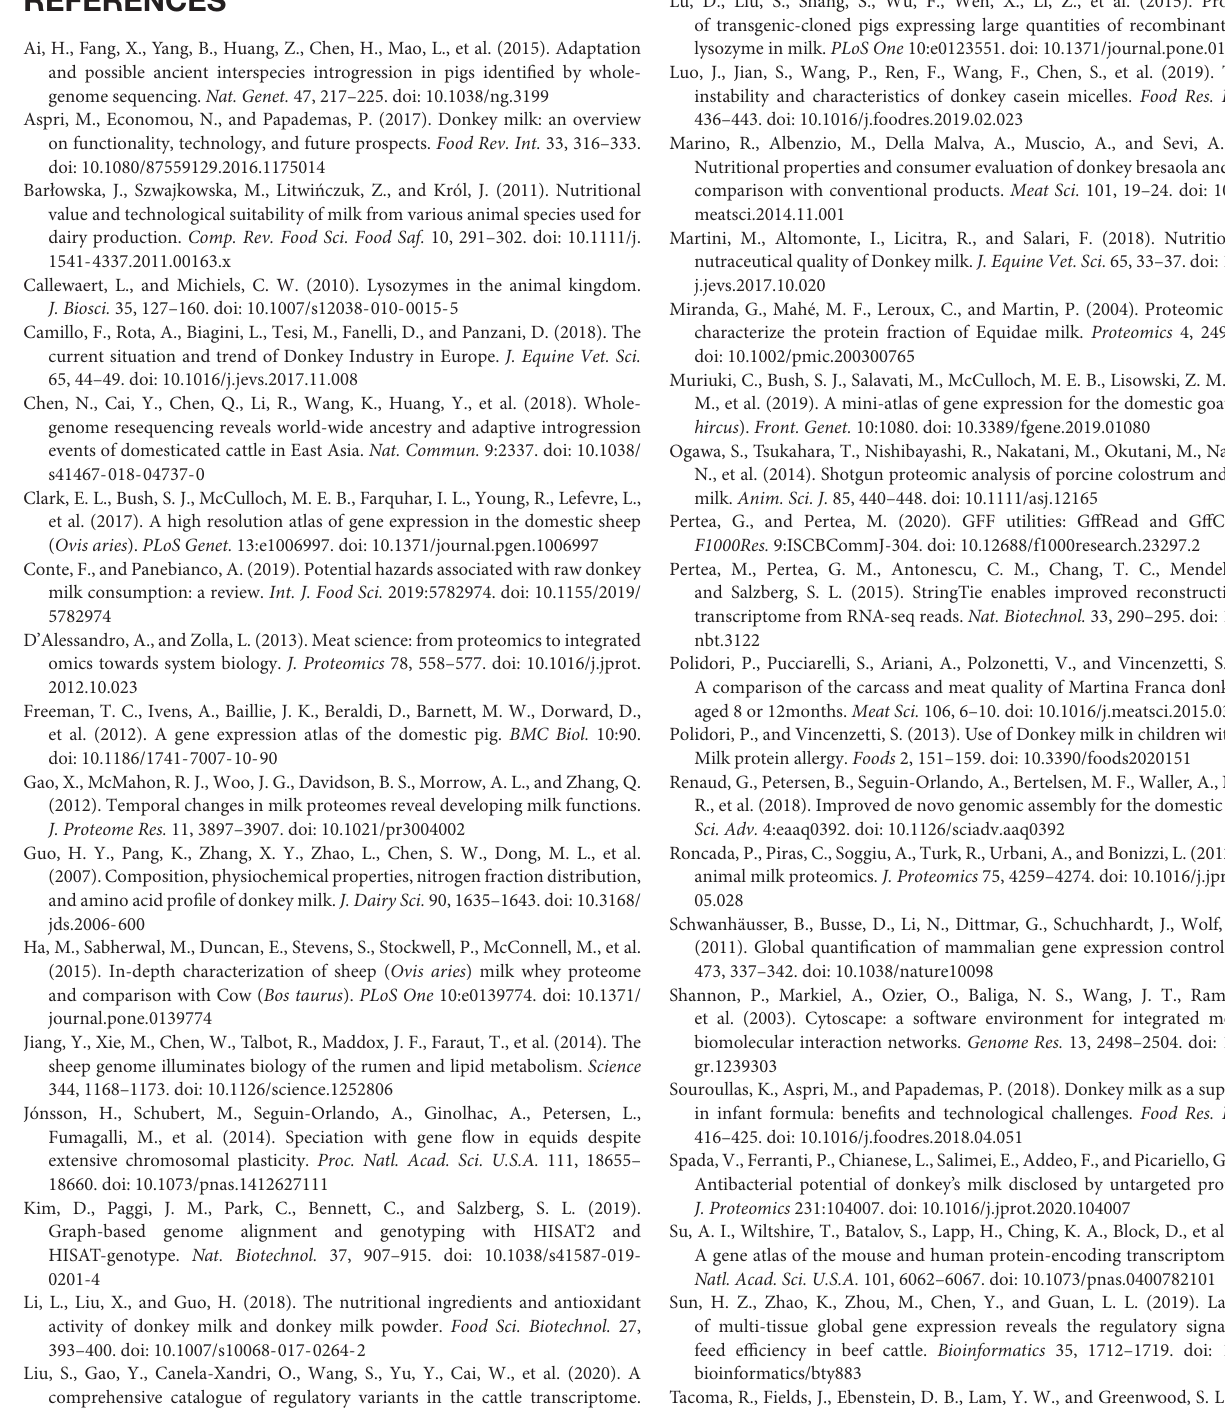
Supplementary Table 5 | Functional Kyoto Encyclopedia of Genes and Genomes pathway analysis for tissue-enriched genes of 16 tissues. Supplementary Table 6 | Functional Kyoto Encyclopedia of Genes and Genomes pathway analysis for ubiquitously expressed genes.